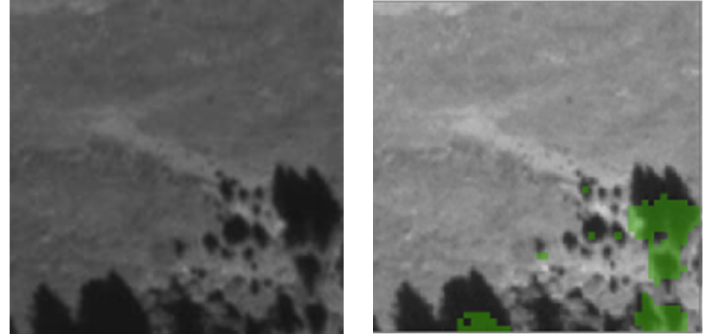
Figure 6. Example (study area 1) of image patch (50 × 50 m) of the “dense forest” class that was removed from the first candidates for training the models. The green pixels have height values >5 m.